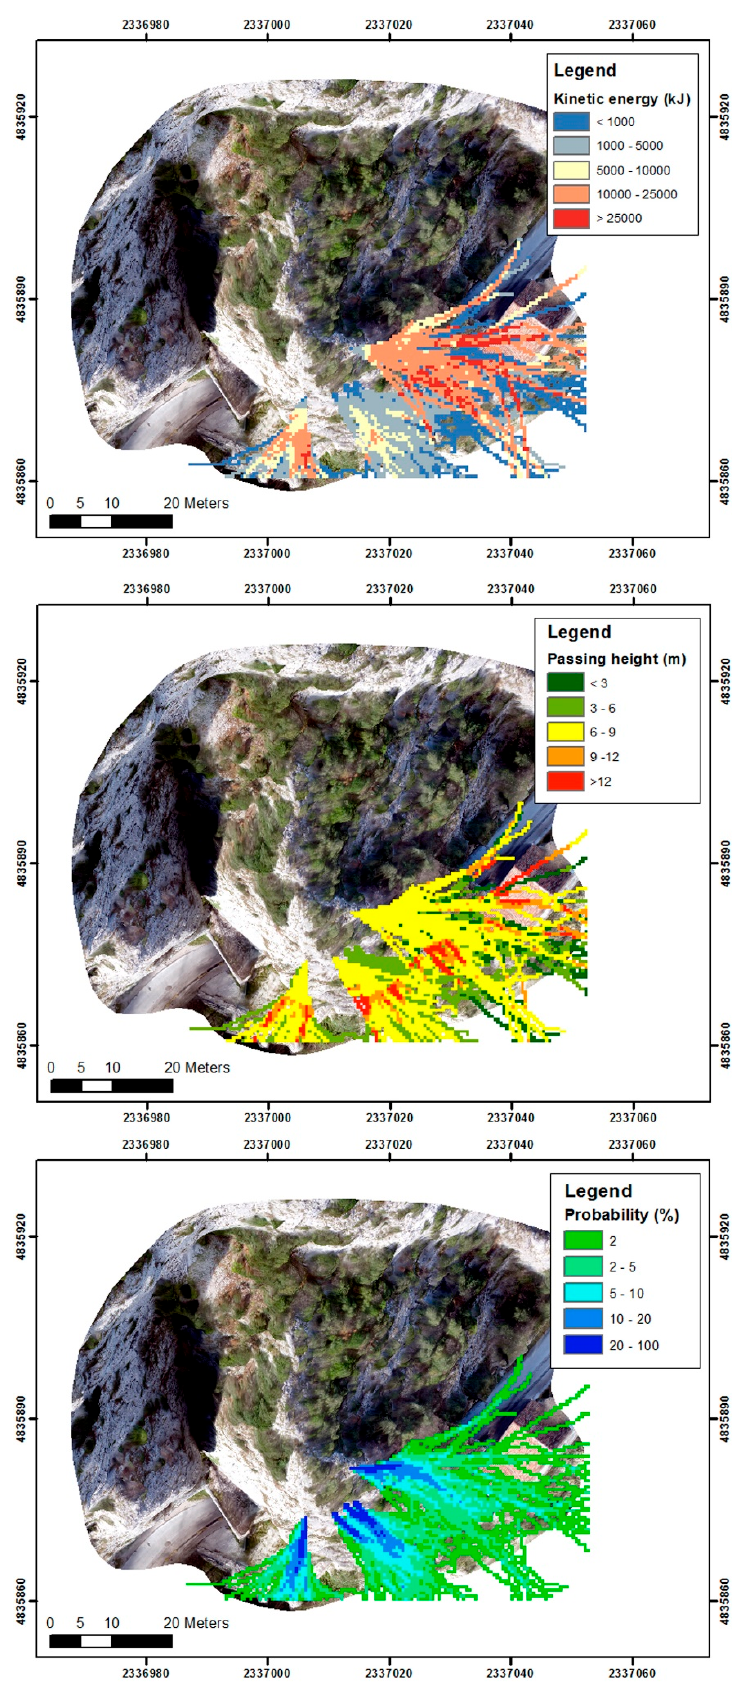
Figure 8. Kinetic energy, passing height, and probability maps of the identified falling rock blocks.